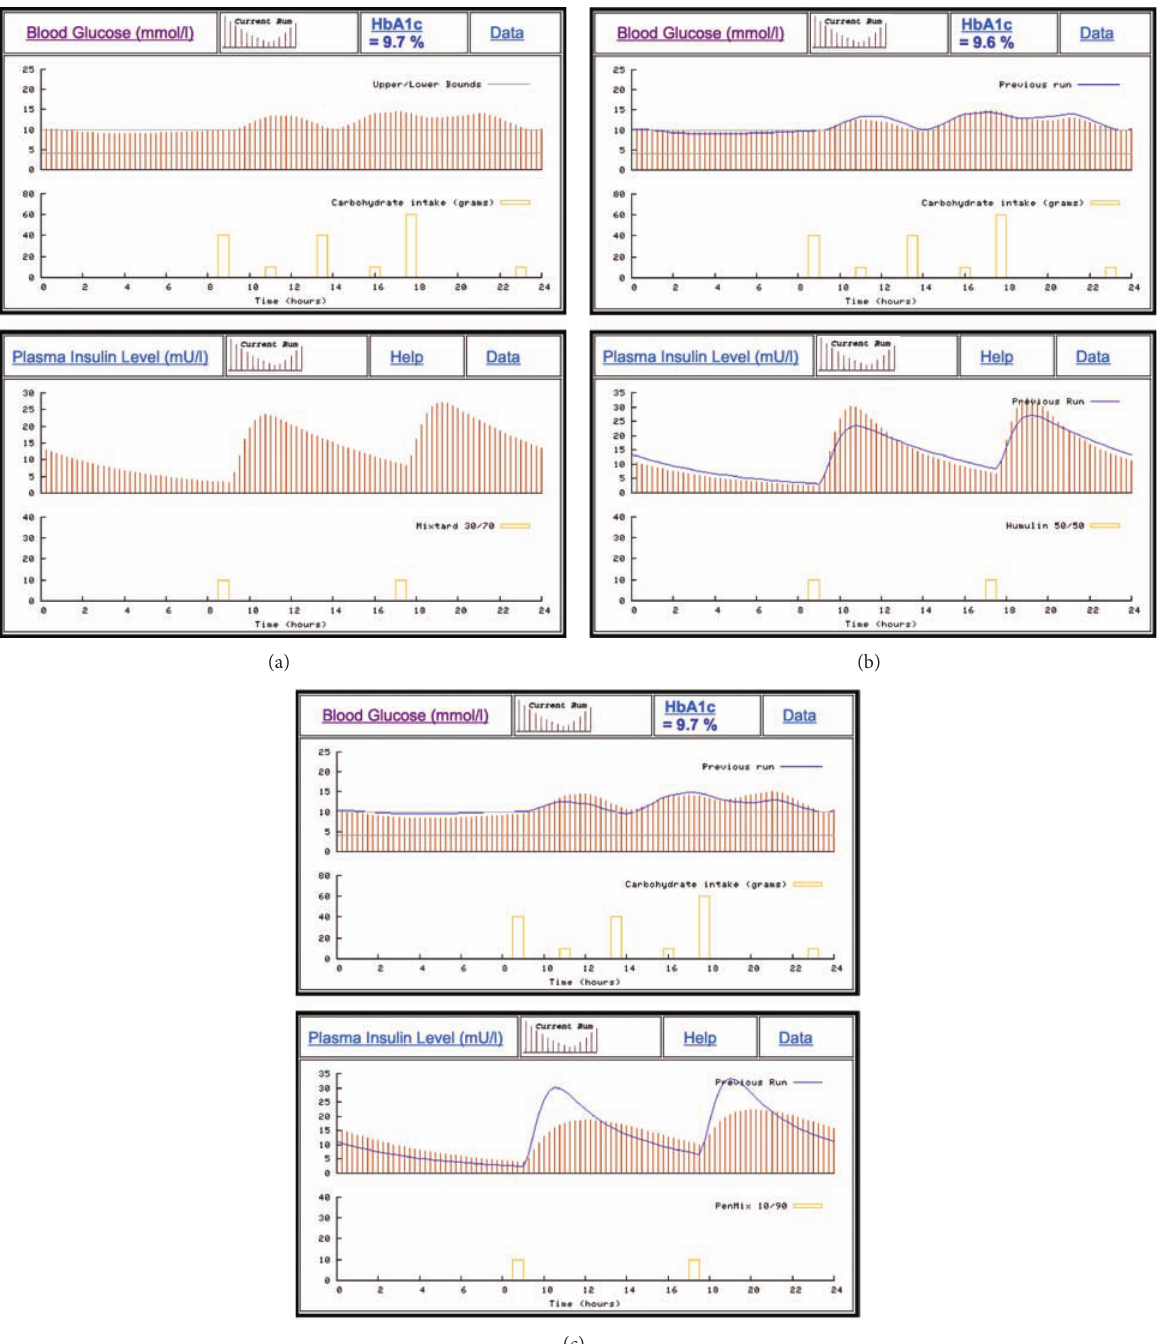
Figure 9: (a) Gives a baseline simulation for case scenario 0026 in the AIDA online database, showing a premixed (biphasic) insulin injection regimen with Mixtard 30/70 being injected twice a day. Mixtard 30/70 is a premixed mixture of 30% short-acting insulin and 70% intermediate-acting insulin. (b) Demonstrates the effect of switching the insulin type from Mixtard 30/70 shown in (a) to Humulin 50/50 (50% short-acting and 50% intermediate-acting insulin) with proportionally more short-acting insulin. The current simulation run is shown as the vertical red lines, with the previous run shown for comparison as the solid blue lines. (c) Demonstrates the effect of switching the insulin type from Humulin 50/50 shown in (b) to PenMix 10/90 (10% short-acting and 90% intermediate-acting insulin) with proportionally more intermediate-acting insulin. The current simulation run is shown as the vertical red lines, with the previous run shown for comparison as the solid blue